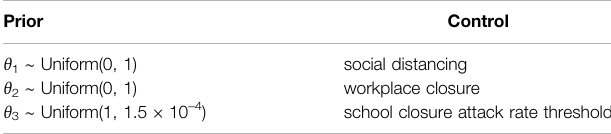
TABLE 2 | Prior over FRED control parameter θ (cid:1) { θ 1 , θ 2 , θ 3 } for COVID-19 simulations.